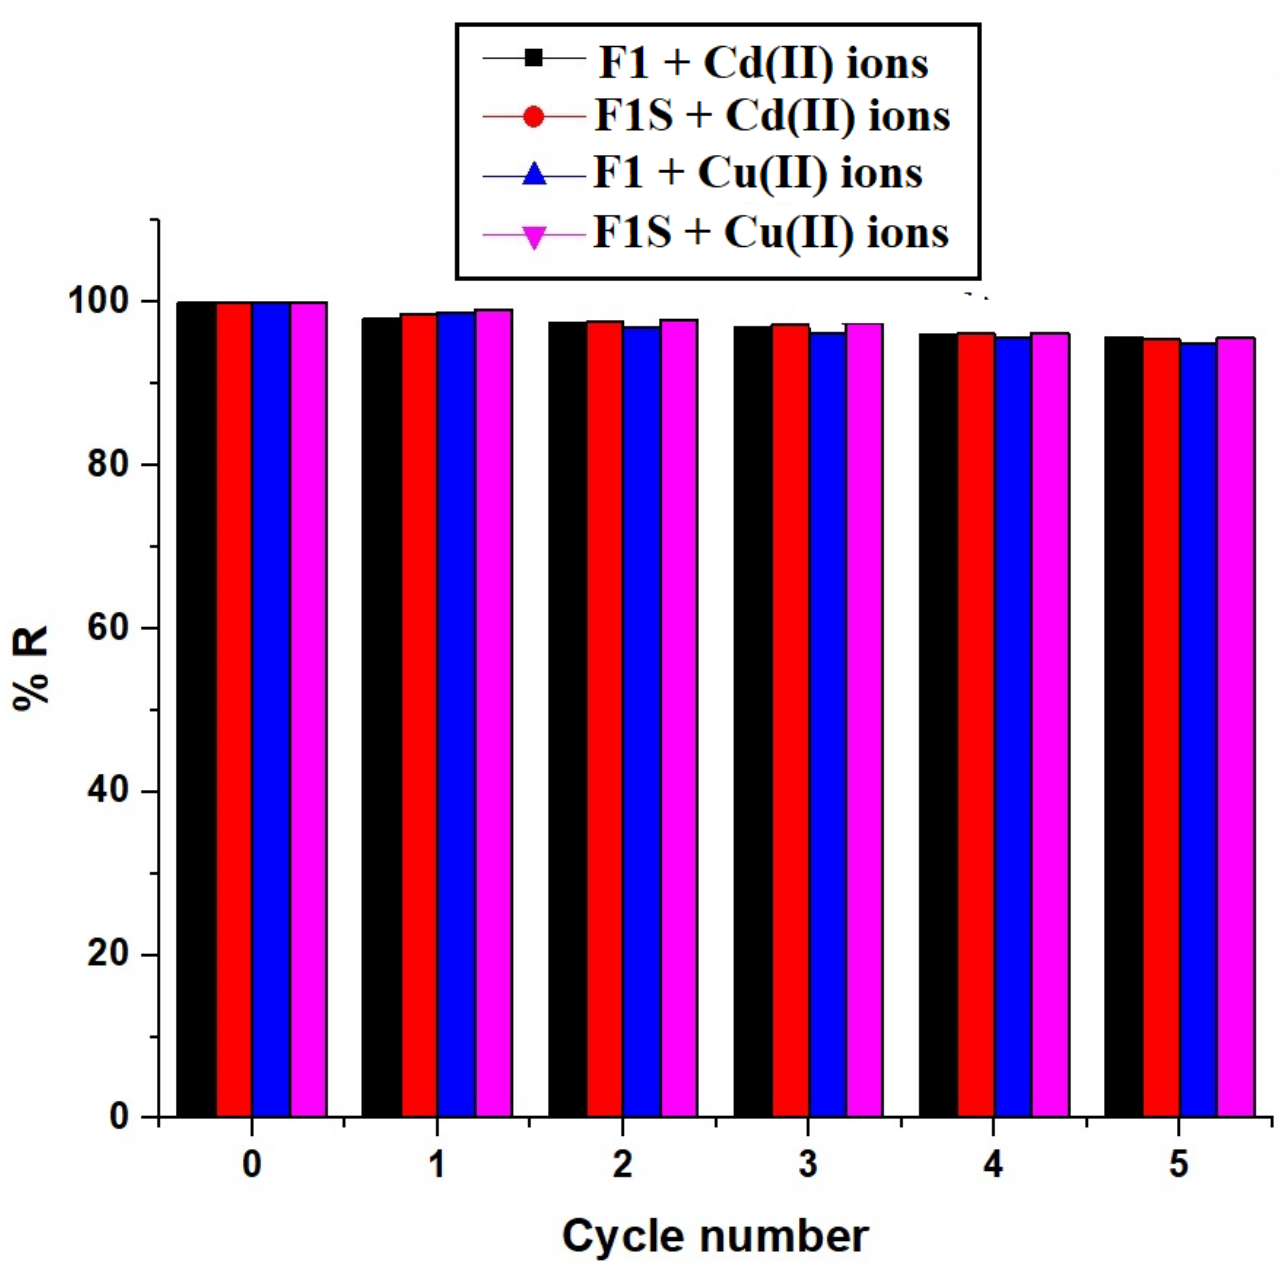
Figure 17. Reusability of the F1 and F1S samples for the adsorption of cadmium and copper ions. Experimental conditions: concentration = 5 mg/L, volume of Cd(II) or Cu(II) solution = 40 mL, amount of adsorbent = 0.04 g, volume of eluting agent = 4 mL, temperature = 298 K, pH = 7.5, and time = 80 min.